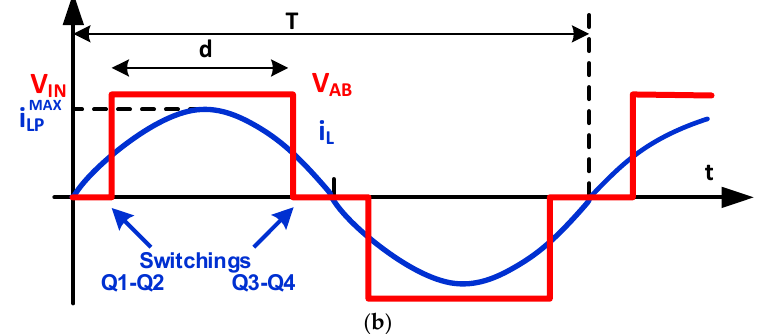
Figure 2. Waveforms for ( a ) Optimum switching control and ( b ) Centered-current control.